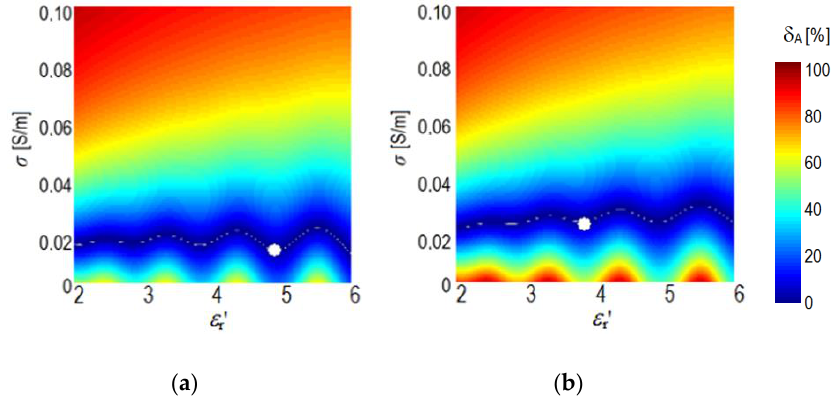
Figure 12. Map of relative error depending on the values ε r ’ and σ for the double-layer wall: ( a ) made of B18 and σ FDTD = 0.01 S / m, ( b ) made of B18 and σ FDTD = 0.02 S / m.